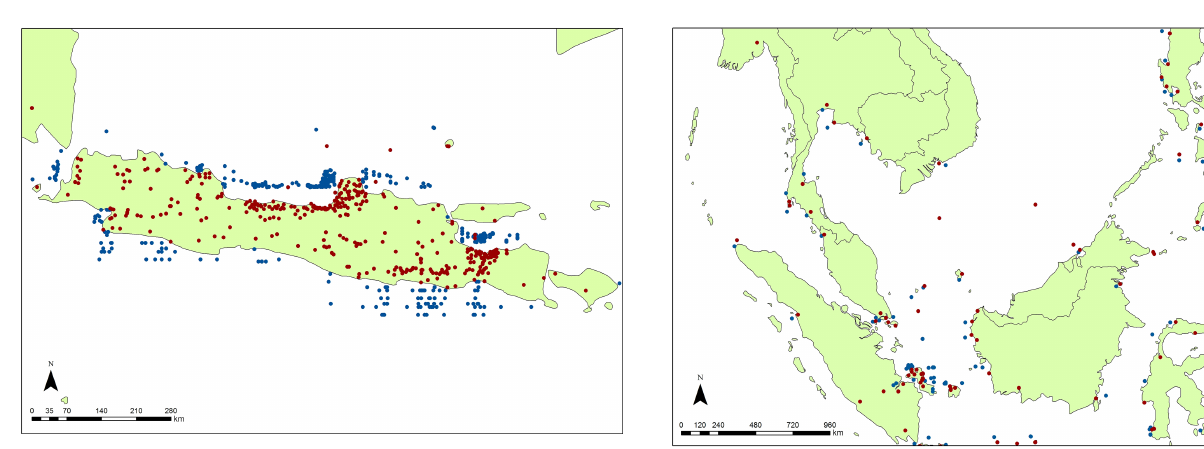
Figure 5. Map of the original station location situated in the ocean (blue dots) and the updated station location (red dots) for Malaysia, Sumatra, Kalimantan, Sulawesi, and parts of the Philippines, Thai- land, Vietnam, and Cambodia.